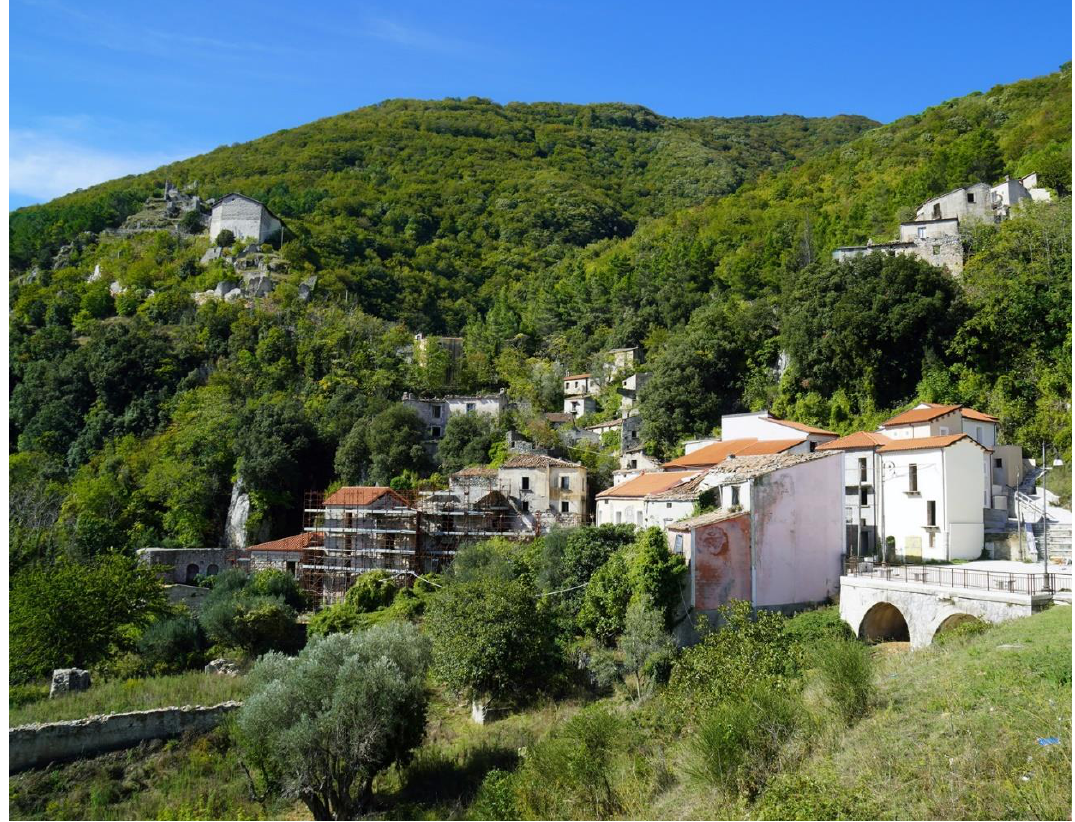
Figure 95. Senerchia: Overview of the remains of the old village (photos by [35,36]).